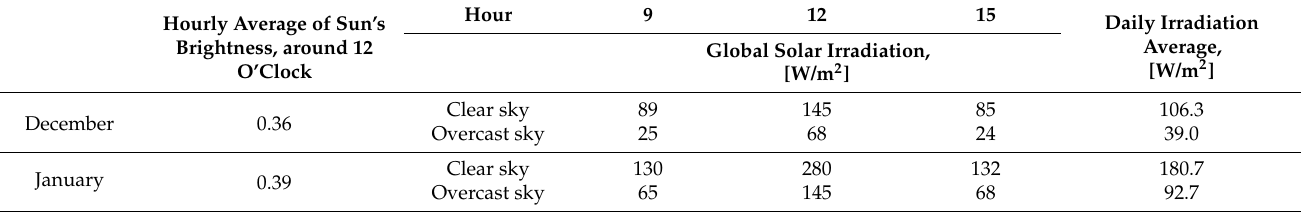
Table 1. Global irradiation includes measurements for both direct and diffused solar radiation. Hourly Average of Sun’s Brightness, around